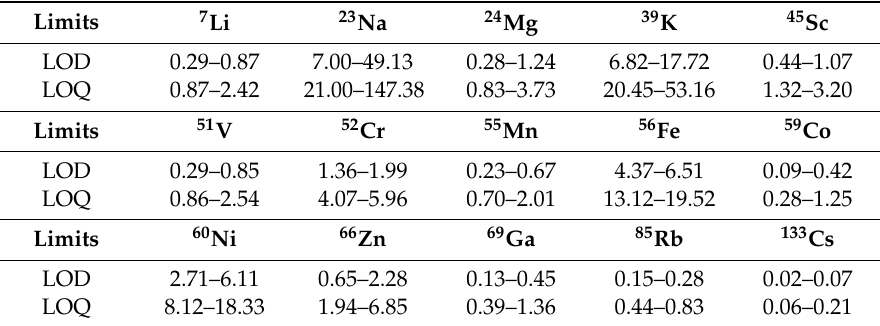
Table 2. LA–ICP-MS detection limits and ranges in